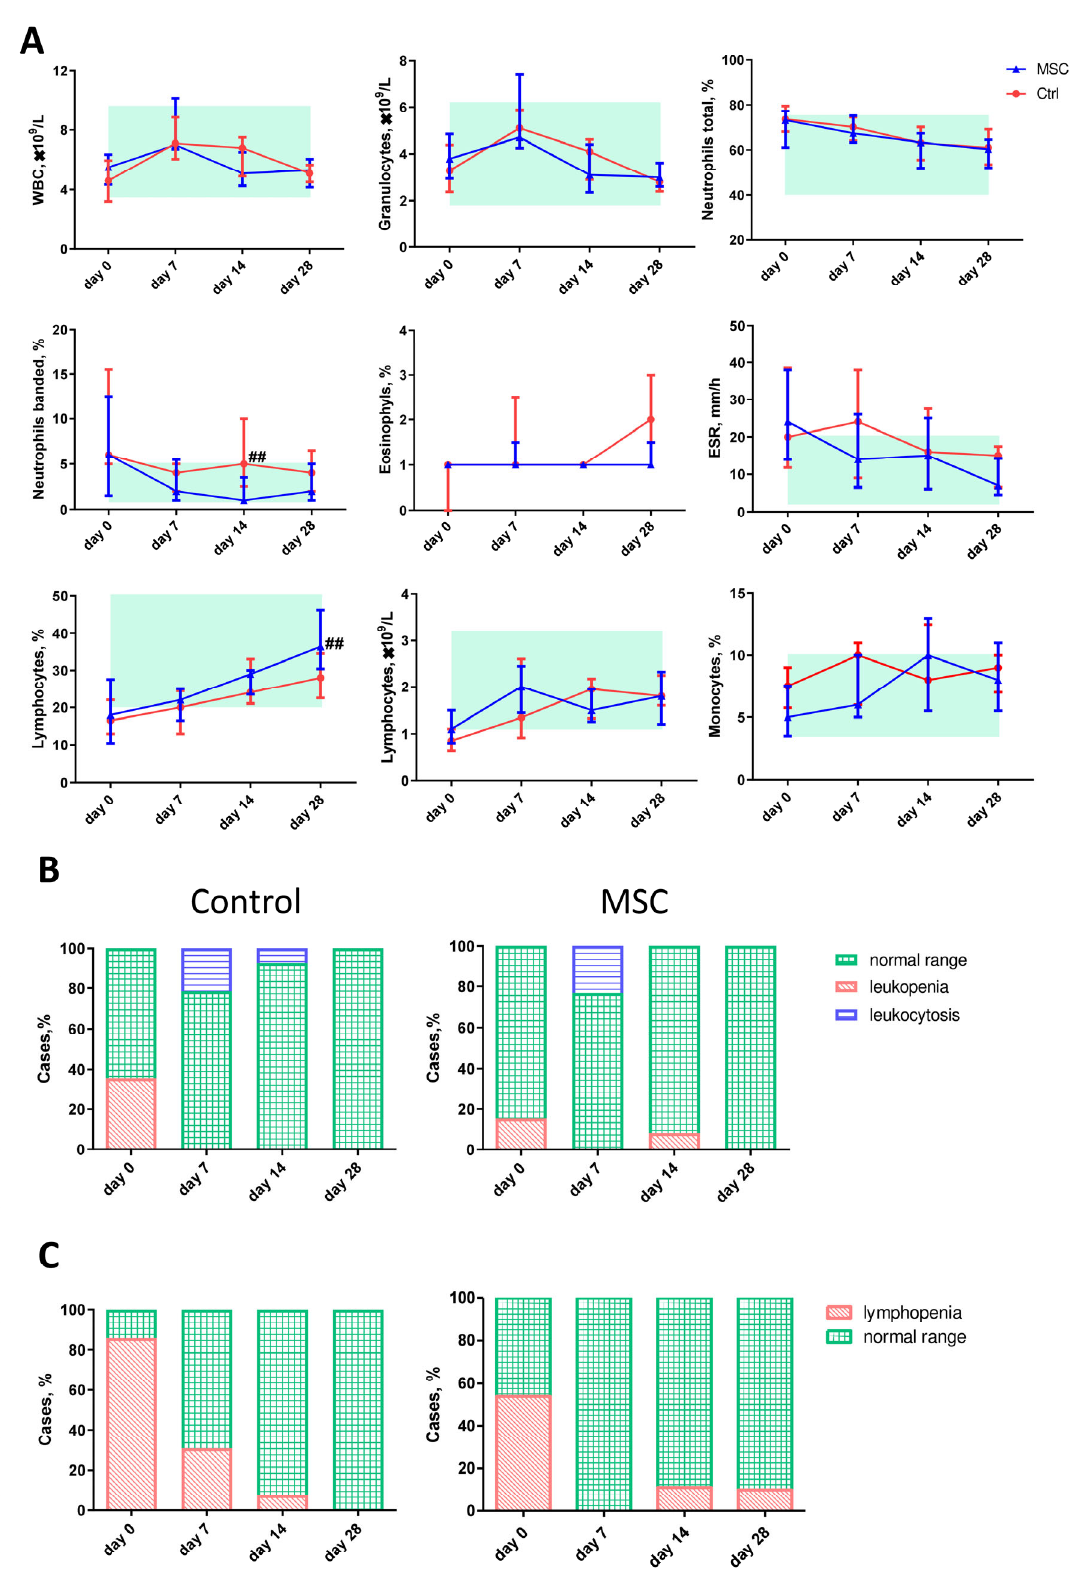
Figure 2. Dynamic changes in hematological parameters in patients with COVID-19. ( A ) The dynamic profile of blood cell types and ESR. A light green rectangle denotes the normal range. ( B ) The ratio of leukopenia and leukocytosis. ( C ) The ratio of lymphopenia. Data are presented as the me- dian and interquartile range. Mann–Whitney U test for comparing the control and MSC groups at